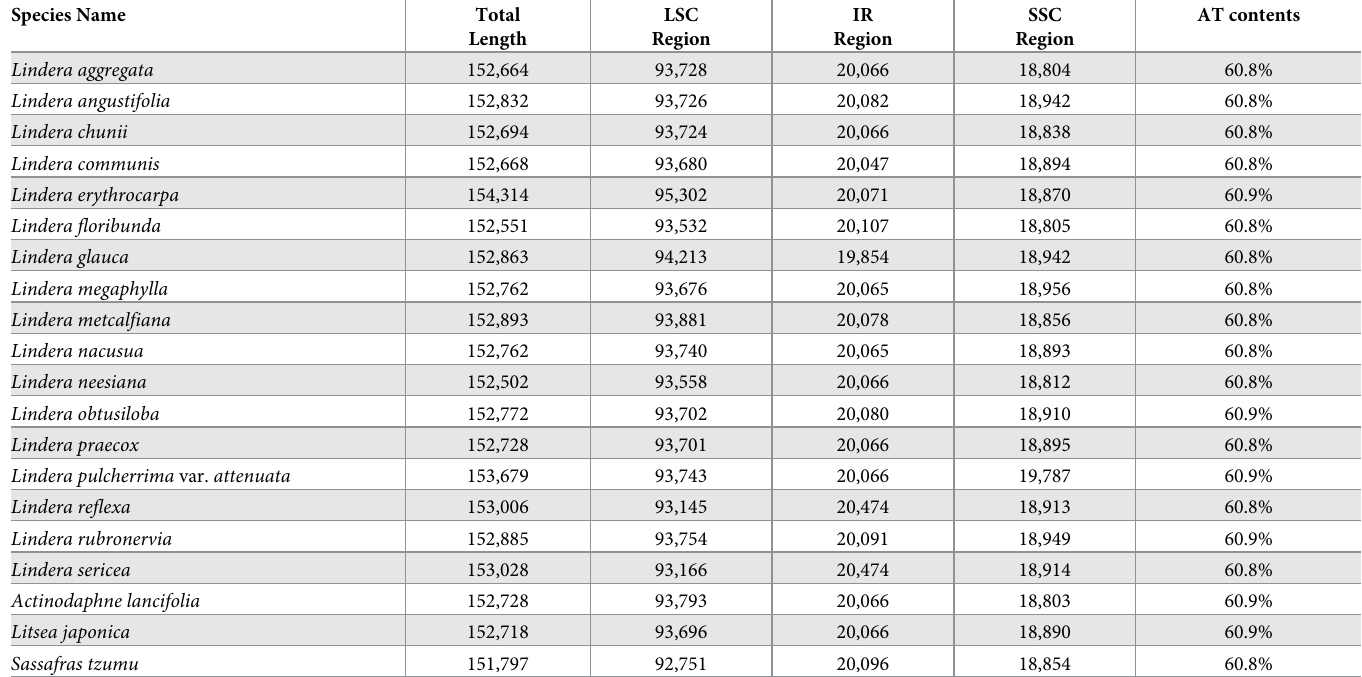
Table 2. Summary of 17 Lindera and the other Lauraceae species complete